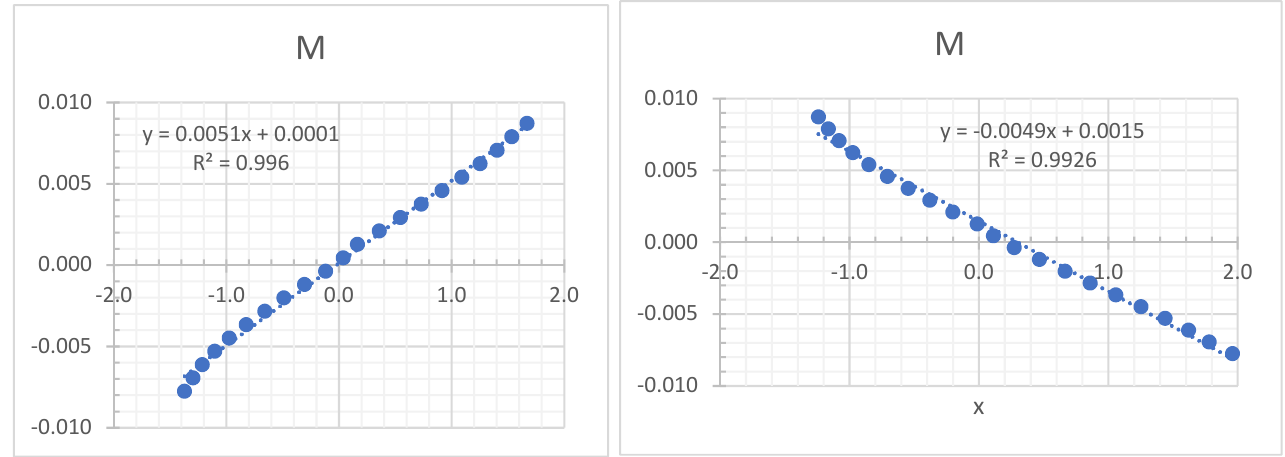
Figure 1. Estimating consensus BS parameter values for the Nadex Gold data of 8 February 2022.